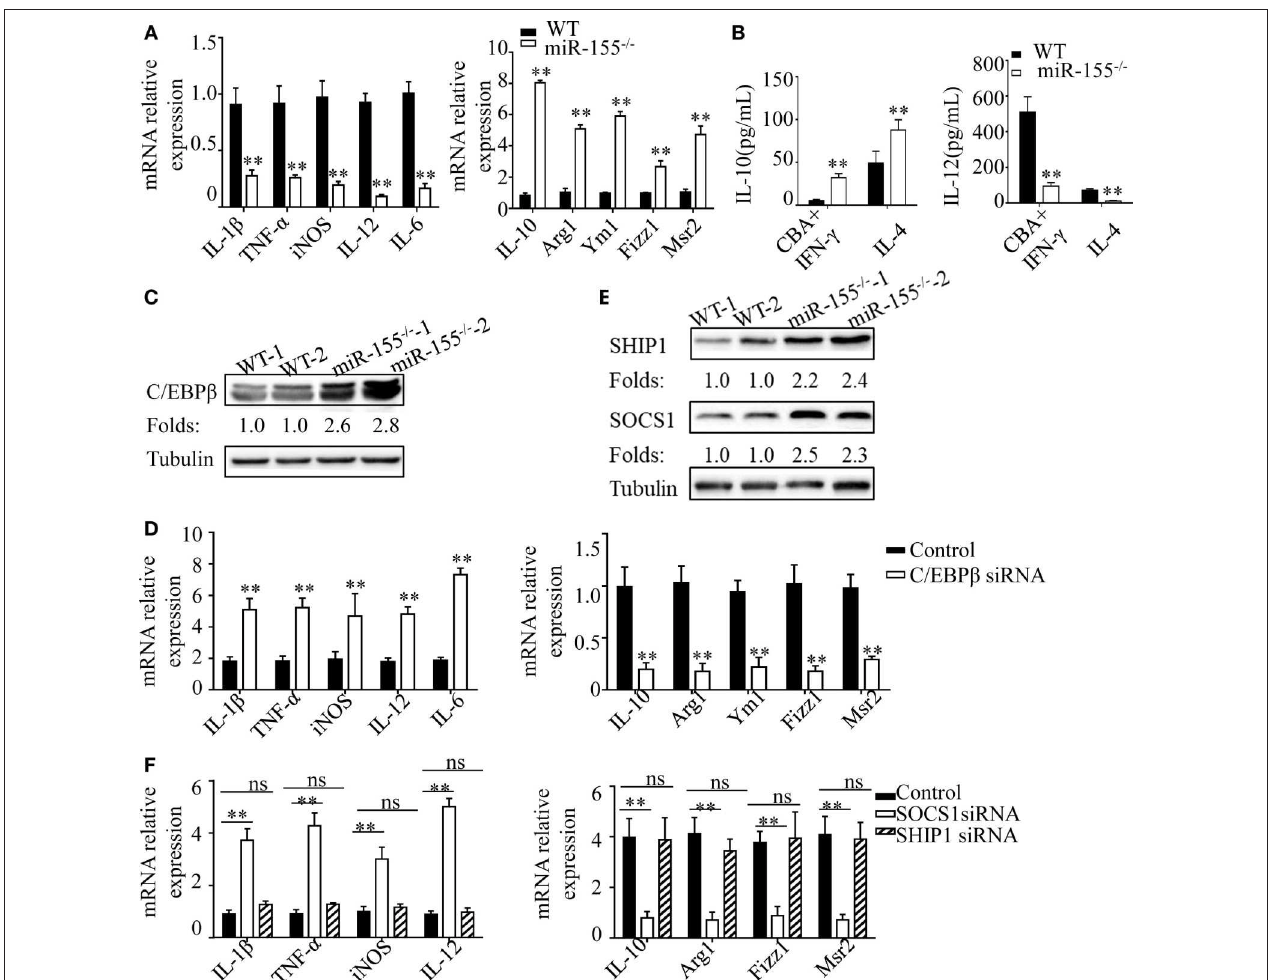
FIGURE 6 | C/EBP β and SOCS1 are key functional targets in intestinal M2 polarization. (A) BMDMs isolated from WT and miR-155 − / − mice were treated with CBA (10 µ g/mL) and IFN- γ (20ng/mL), and the relative expression of M1genes and M2 genes were determined by Q-PCR. (B) The absolute amounts of secreted cytokines IL-10 and IL-12 (as representative of M2 and M1 gene products, respectively) in the supernatants of WT or miR-155 − / − BMDMs that had been treated with M1 condition (CBA + IFN- γ ) and M2 condition (IL-4) were measured by ELISA. (C) The protein expression level of C/EBP β in macrophages (CD11b + CD11c − / low ) isolated from LPMCs of dextran sulfate sodium colitis mice were determined by western blotting. (D) miR-155 − / − BMDMs were transferred with C/EBP β siRNA or control and then stimulated with CBA (10 µ g/mL) and IFN- γ (20 ng/mL), and the relative expression of M1genes and M2 genes were determined by Q-PCR. (E) The protein expression level of SOCS1 and SHIP1 in macrophages, as described in (C) , was determined by western blotting. (F) miR-155 − / − BMDMs were transferred with SOCS1 and SHIP1 siRNA and treated as described in (D) , and the relative expressions of M1genes and M2 genes were determined by Q-PCR. * P < 0.05,** P < 0.01 vs WT control or siRNA control [Student’s t -test in (A,B,D) ]. * P < 0.05, ns > 0.05 vs. siRNA control (ANOVA with Bonferroni’s posttest correction for multiple comparisons in (F) . Data are representative of three independent experiments (mean and SD). Ns, not significant. BMDMs, bone marrow-derived macrophage. WT, wild-type. CBA, cecal bacterial